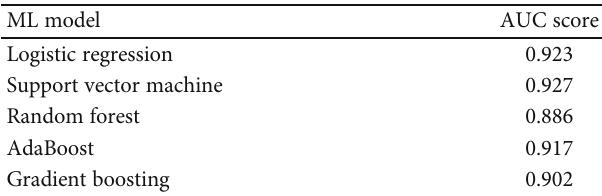
Figure 2: The SNPs with statistical signi fi cance organized by the strength of association to AF among PRH. Table 4: Machine learning analysis for the best predictive model fi